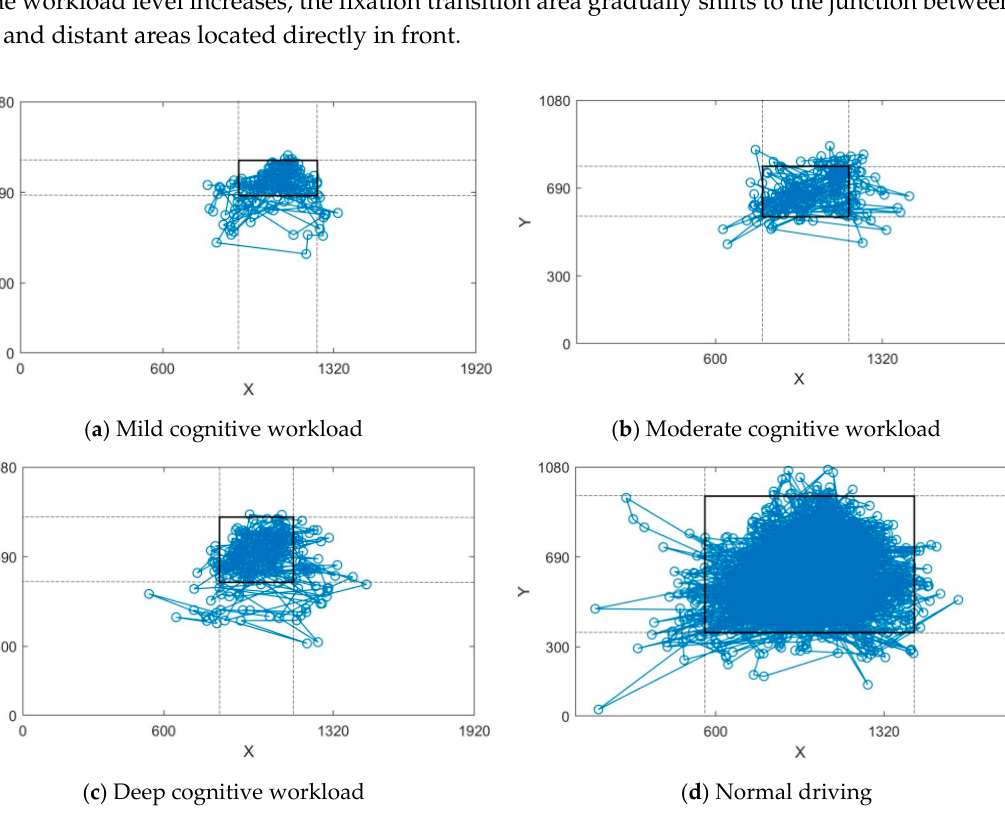
Figure 9. Schematic diagram of the competition between visual and cognitive attention under different states. 4.2.2. Visual Attention Transition Characteristics in Various Areas Areas A and B belong to the left side of the current driving lane; areas D and E belong to the front of the current driving lane; and areas G and H belong to the right side of the current driving lane. These areas are divided for analysis in the statistical data. The one- and two-step transition